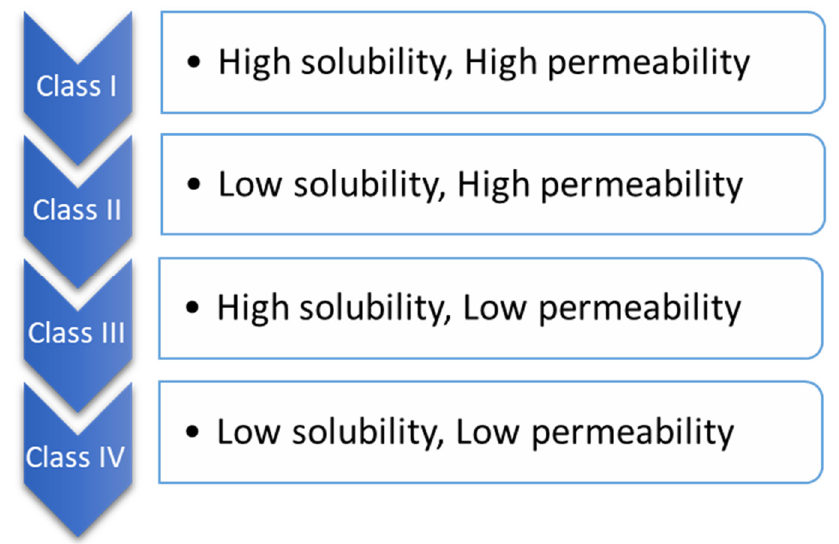
Figure 2. Biopharmaceutical classification.